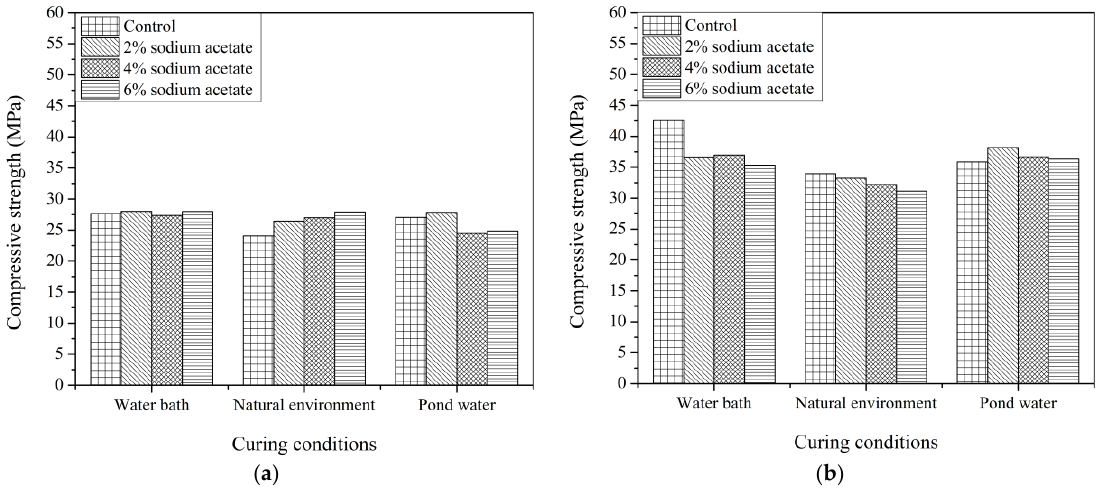
Figure 4. Compressive strength of PCC pavement after a curing period of: ( a ) 7 days and ( b ) 28 days.